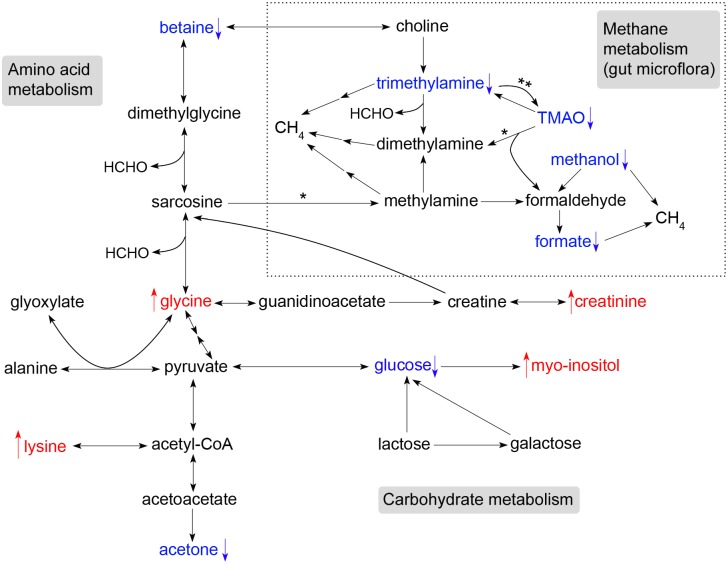
Metabolic pathways involved in postnatal lamb development.Metabolites indentified in Table 2 are summarized according to their occurrence in metabolic pathways as annotated by KEGG metabolic pathways. ↓, metabolites decreasing with age (blue); ↑, metabolites increasing with age (red). TMAO, trimethylamine N-oxide; HCHO, formaldehyde; CH4, methane. The reactions contained in the boxed section are likely to be derived from rumen microbial metabolism, except for reactions denoted by **, which occur in mammalian tissues [63], [84], and reactions denoted by *, which can occur both in mammalian tissues or the gut microbiome [85]. This representation of the data recognises that plasma metabolites report the combined metabolic activities of all major tissues as well as the rumen microbiome.